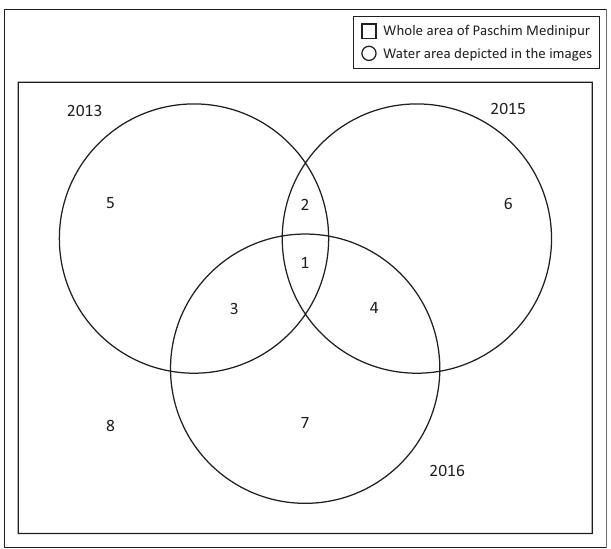
FIGURE 5: Computational protocol of flood affected frequency.